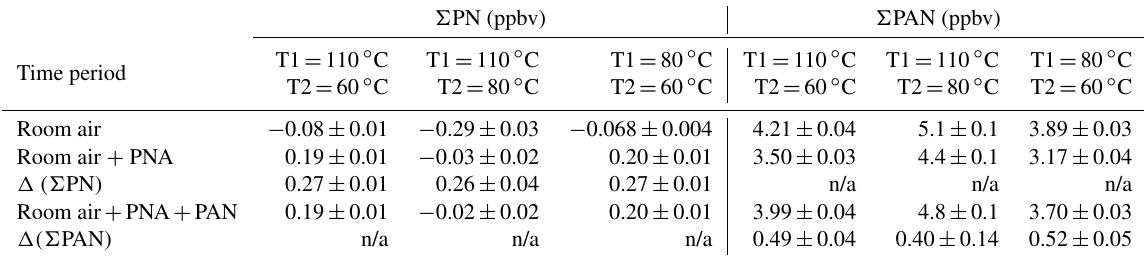
Table 7. Statistics (average ± 1 standard deviation) of the 1s data of laboratory air (first time period), laboratory air spiked with ∼ 260pptv PNA (second period), and laboratory air spiked with 260pptv PNA and ∼ 480pptv PAN (third